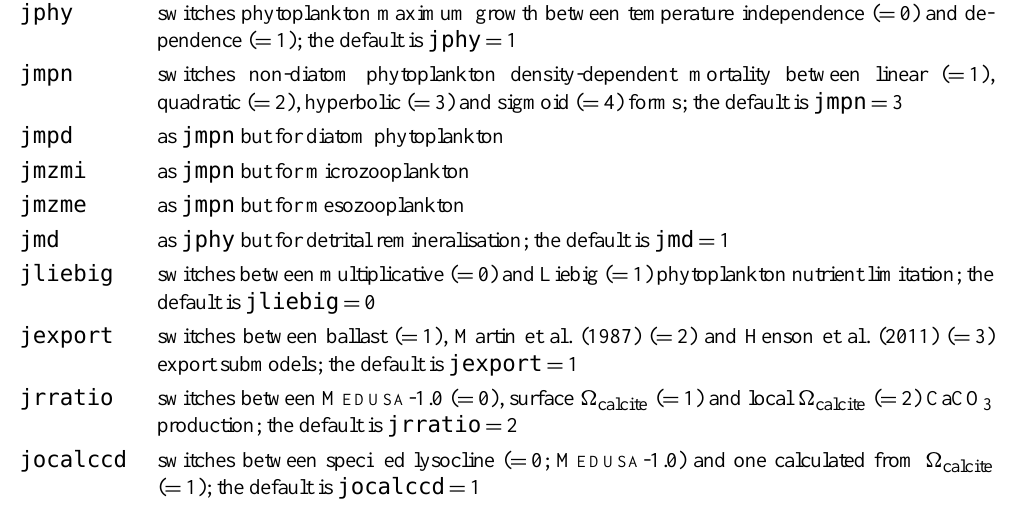
Table 6. M EDUSA -2.0 switches.